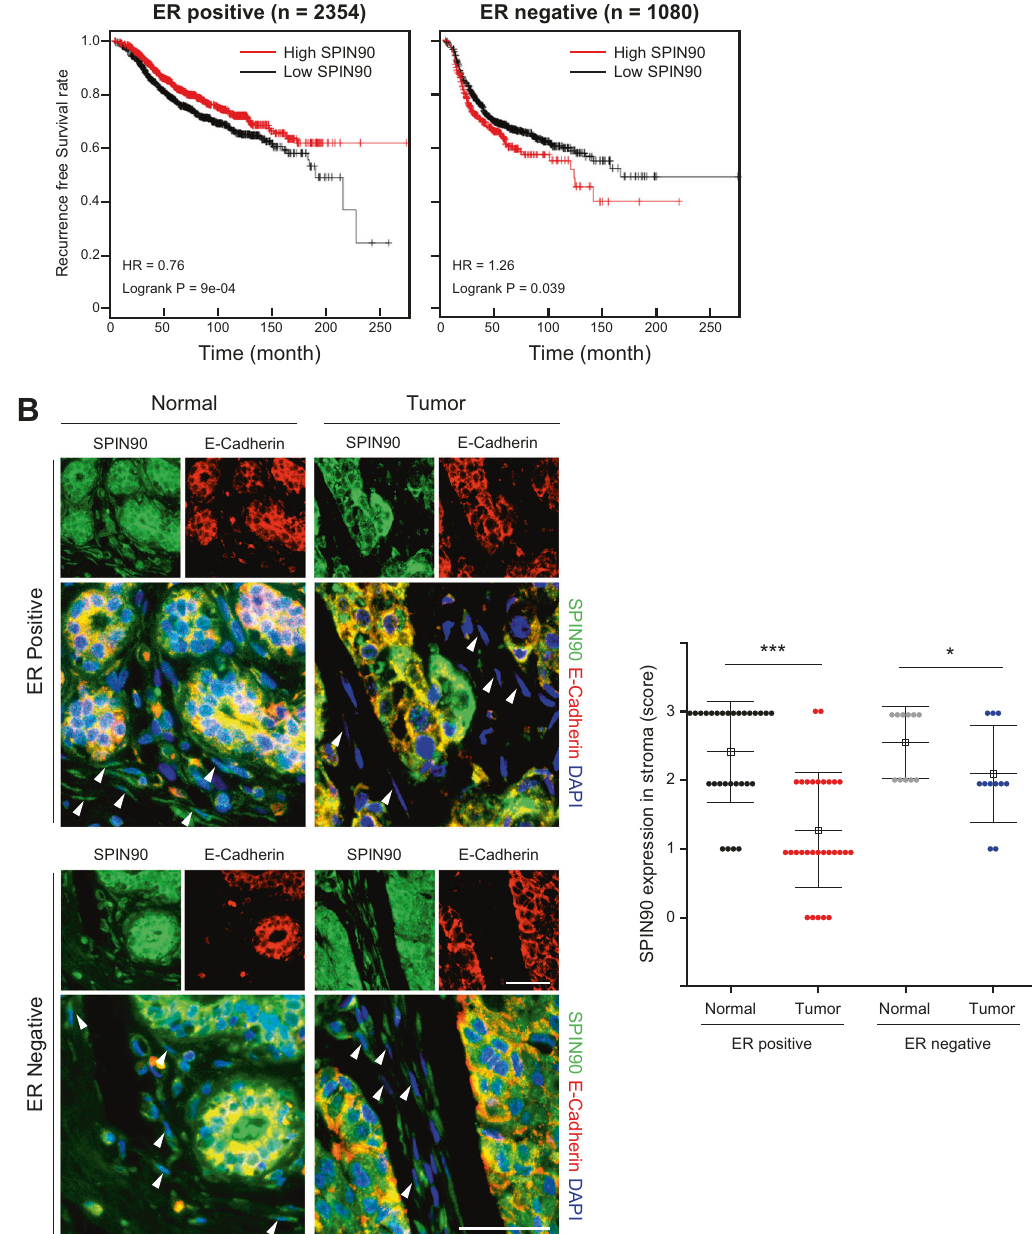
Fig. 1 SPIN90 is signi fi cantly downregulated in CAFs of ER-positive breast cancer patients. A KM plots of recurrence-free survival in ER- positive ( n = 2354) and ER-negative ( n = 1080) breast cancer patients according to Spin90 level. Outlier data were removed for quality control. HR hazard ratio. B Representative IHC images showing expression of SPIN90 (green) and the epithelial cell marker E-cadherin (red) in breast cancers and paired normal stroma from ER-positive ( n = 29) and ER-negative ( n = 11) samples in a tumor microarray (BR804b). The white arrows indicate stromal fi broblasts. The graph shows the relative intensity score of SPIN90 in stroma as follows: 0 = negative, 1 = weak, 2 = moderate, 3 = strong. The images were scanned with an Olympus research slide scanner and analyzed using the Olympus cellSens and ImageJ software packages. Scale bar, 50 μ m. All data are presented as mean ± standard deviation. * p ≤ 0.05; *** p ≤ 0.001 (Student ’ s t